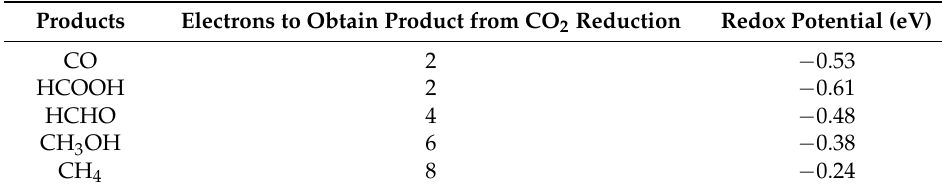
Table 1. Electrons required to reduce CO 2 to C 1 hydrocarbons